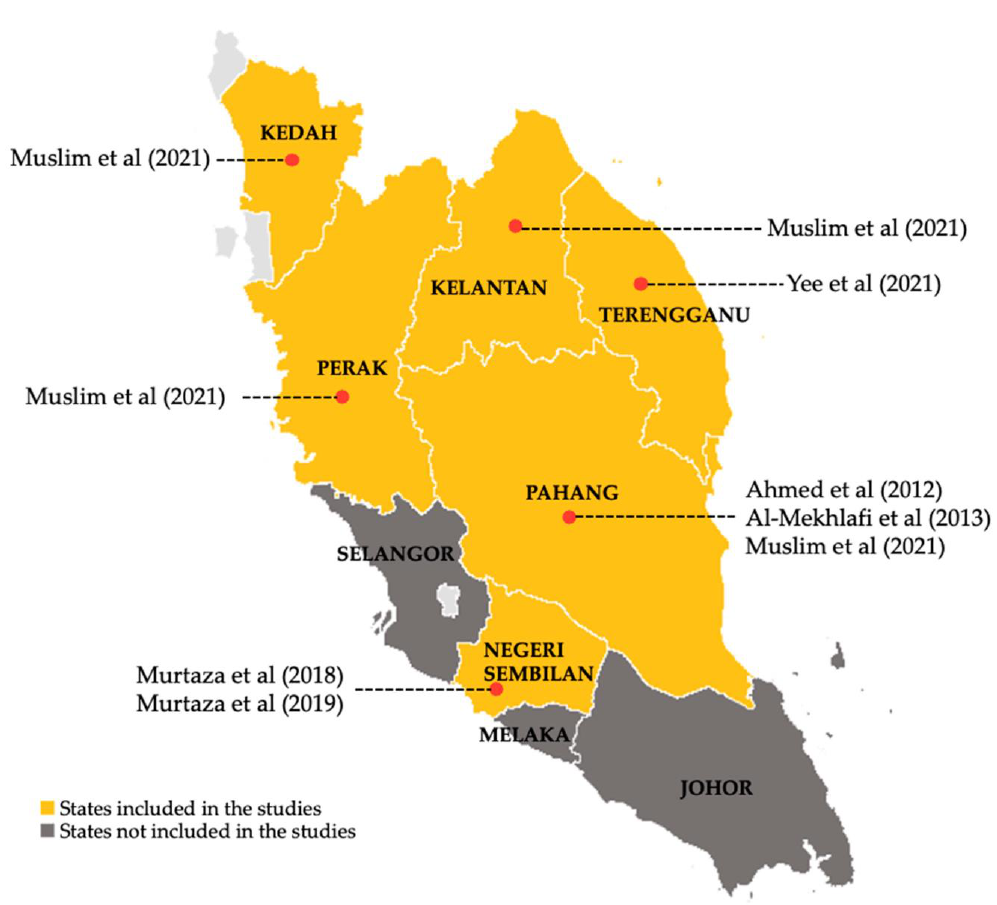
Figure 2. Locality of Orang Asli children population participated in the studies [24 – 29].